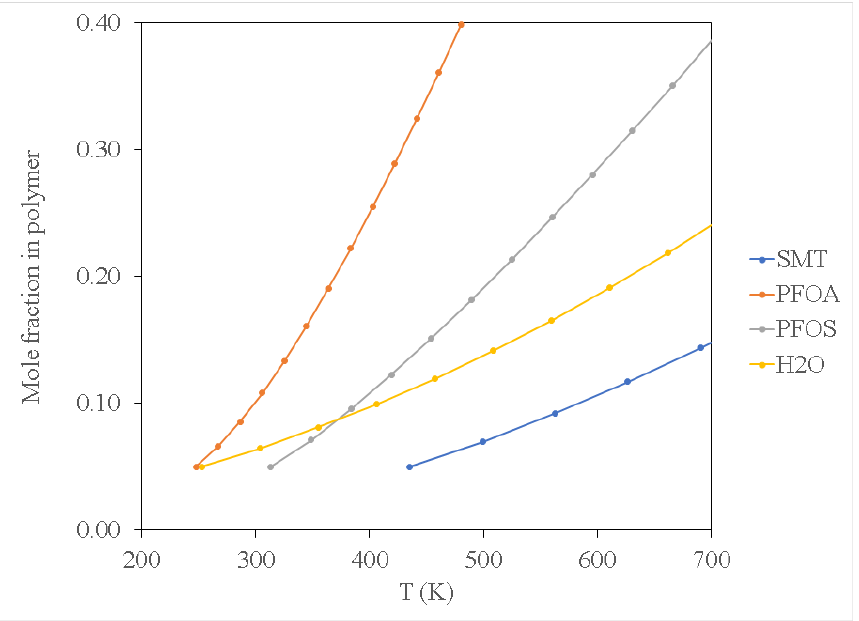
Figure 7. Effect of temperature on sorption in PP with respect to a fixed value of Np = 1000.